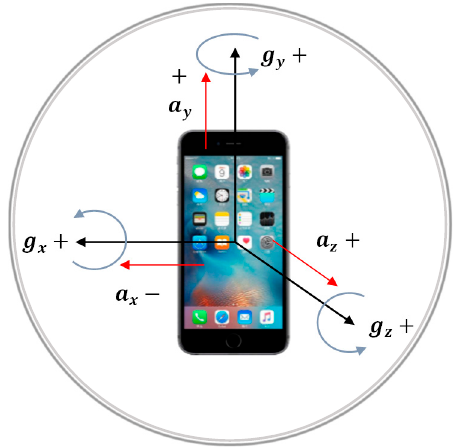
Figure 3. The three-axis coordinate system of built-in sensors.